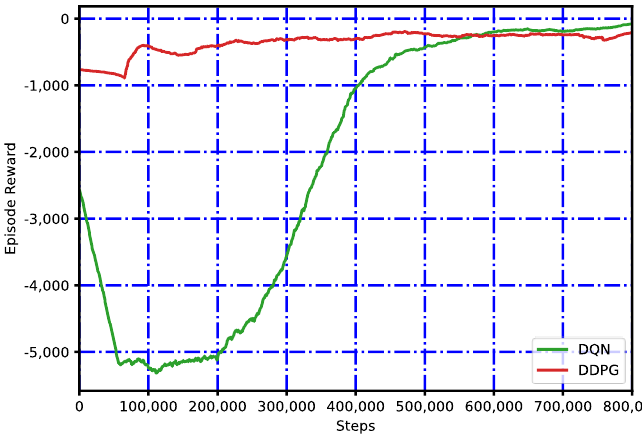
Figure 8. Reward per episode during the agent